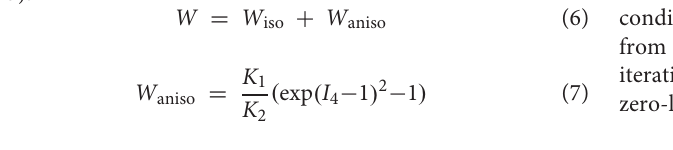
LV inner-pressure conditions were prescribed as (Tang et